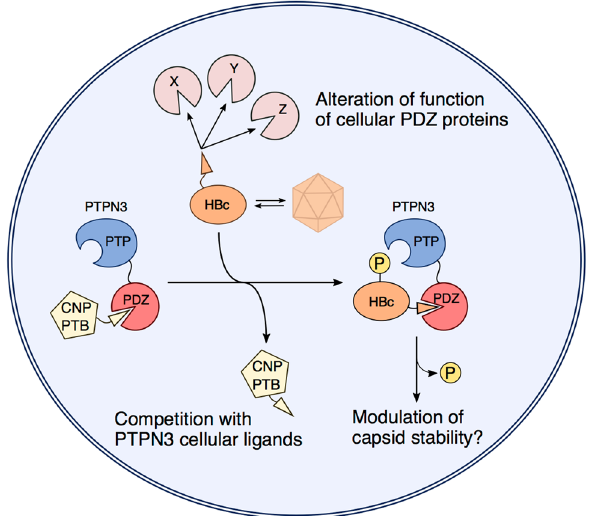
Figure 6. Schematic model of the multiple PBM-mediated interactions of HBc with PTPN3 and other PDZ- containing proteins. The model illustrates the competition of HBc with PTPN3 cellular ligands (CNP, PTB). The subsequent complex formed between the two proteins could allow the dephosphorylation of HBc by PTPN3, potentially affecting capsid stability. HBc could also target and alter functions of other cellular PDZ-containing proteins (proteins X, Y,